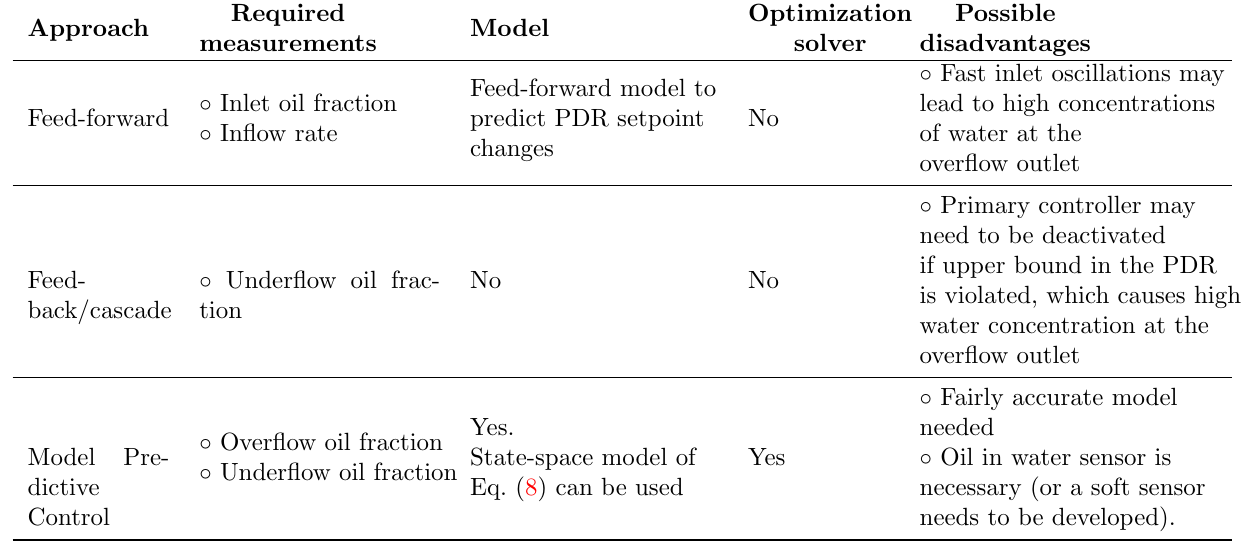
Table 1: Comparison of the three approaches used for controlling the underflow oil fraction of a hydrocyclone.